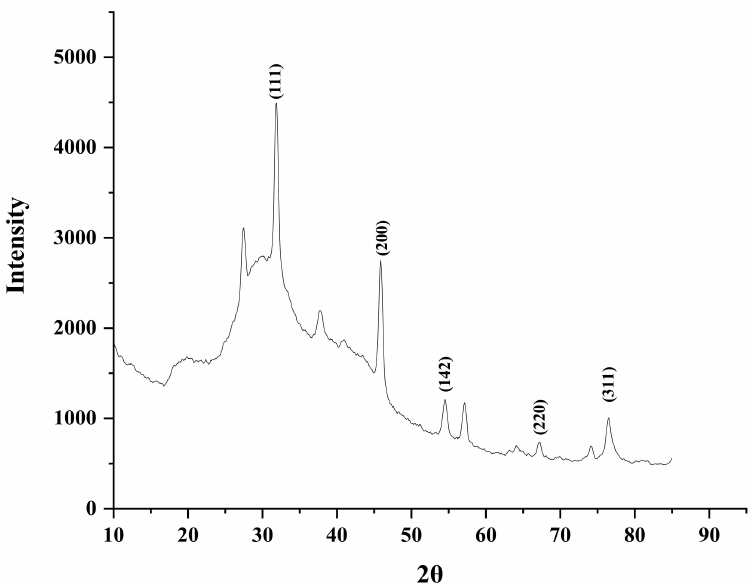
Figure 7. XRD spectra of prepared silver